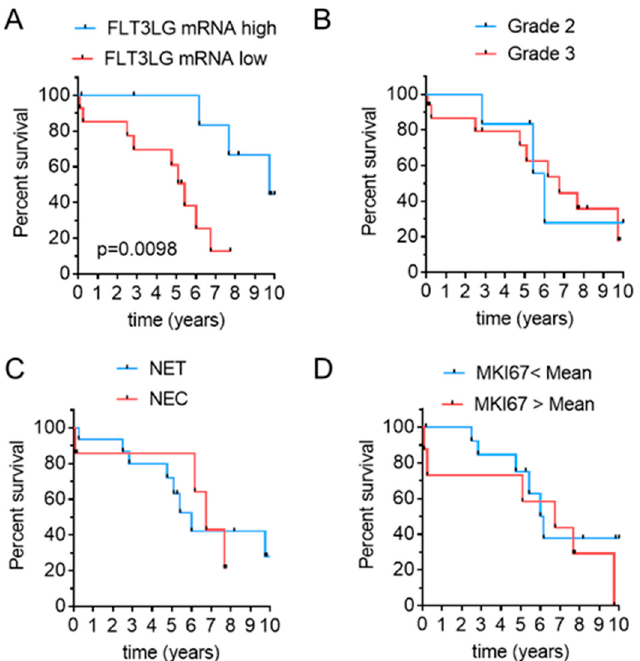
Figure 2. High FLT3LG mRNA expression predicts better survival. ( A ) Kaplan–Meier curves for estimation of disease-related survival in patients with high (log2 FLT3LG mRNA > 3.72, blue) or low (log2 FLT3LG mRNA < 3.72, red) tumoral FLT3LG expression. Follow-up was restricted to 10 years. Median survival was 117 months in FLT3L “high” compared to 65 months in FLT3LG “low“ samples, Hazard Ratio (HR) 0.2404, 95% confidence interval (CI) 0.0716 to 0.8073, n = 22. ( B – D ) Kaplan–Meier curves for the same cohort following stratification according to tumor grade ( B ), morphological differentiation (i.e., well differentiated NET versus poorly differentiated NEC) ( C ), or MKI67 mRNA expression obtained from the RNAseq data ( D ). Median survival was 72 months in G2 versus 82 months in G3 samples (HR1.007, 95%CI 0.266 to 3.804), 72 months in NET versus 81 months in NEC (HR0.799, 95% CI 0.223 to 2.855), and 81 months compared to 74 months in tumors with MKI67 mRNA above or below mean (HR 1.51, 95% CI 0.476 to 4.808). p > 0.05 for ( B ) to ( D ).